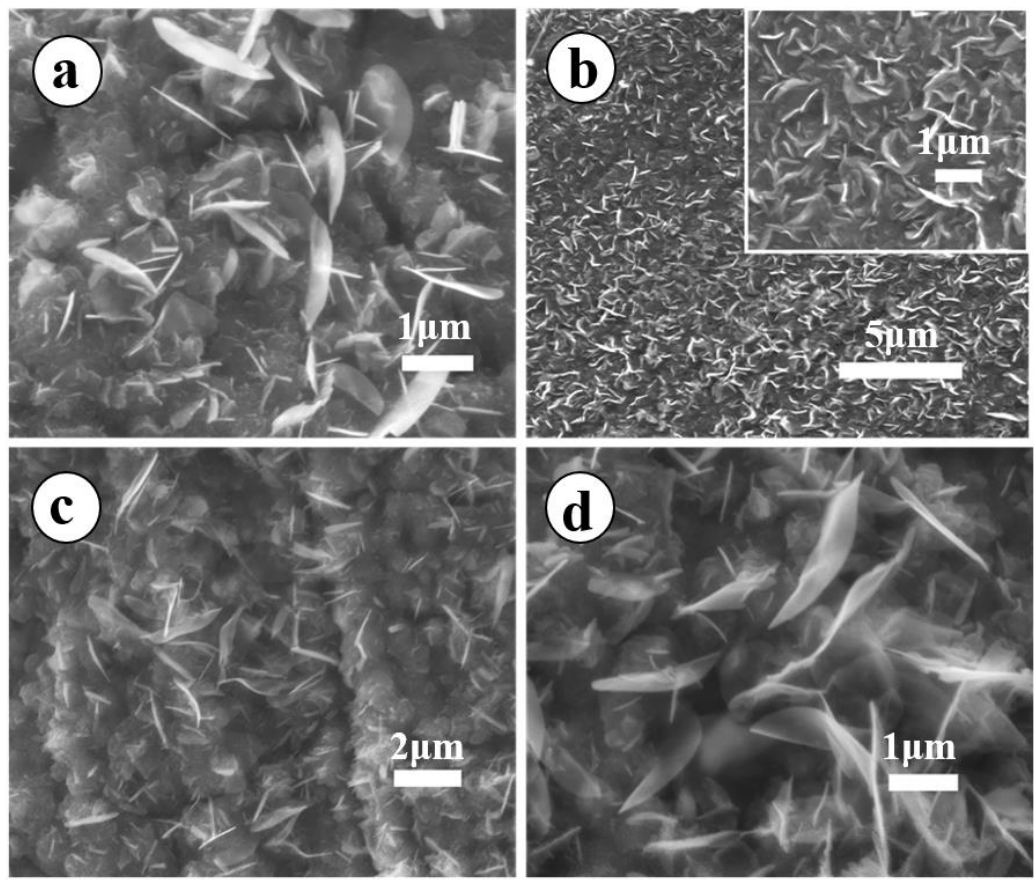
Figure 3. SEM images of MONs grown on the stainless steel at ( a ) 30 min; ( b ) 1 h; ( c ) 2 h; ( d ) 3